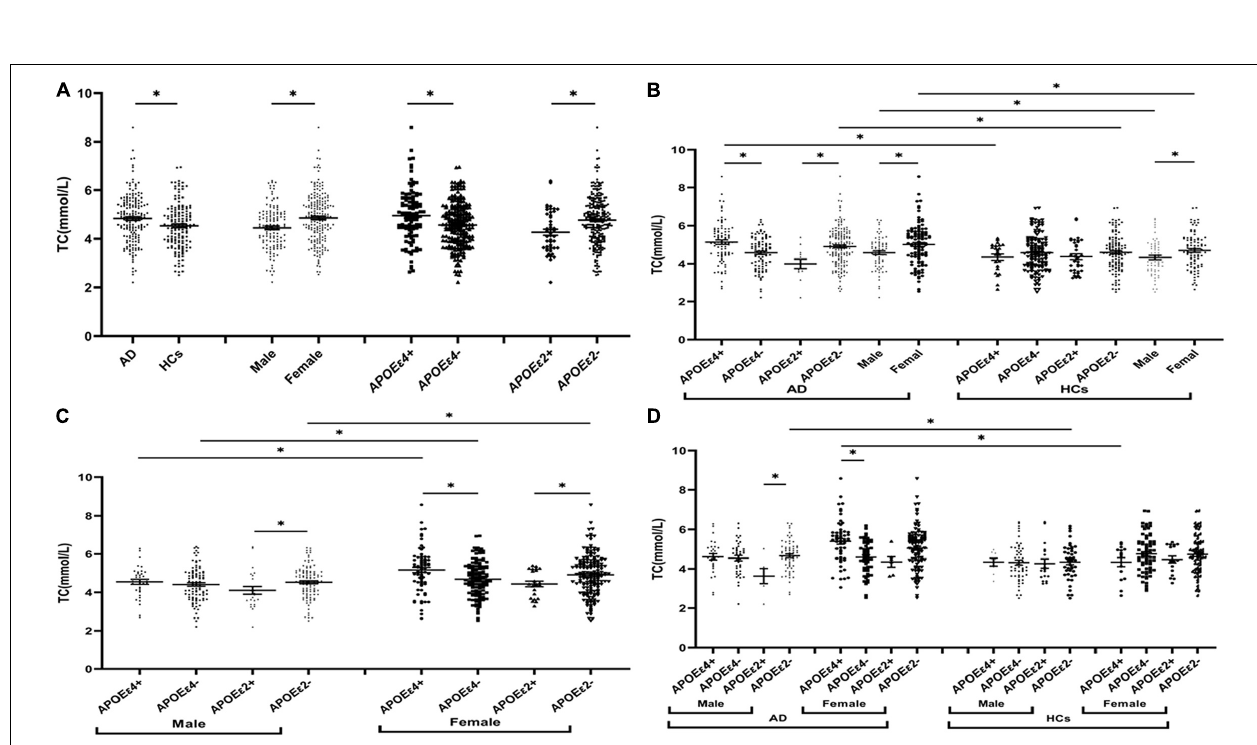
FIGURE 2 | The levels of TC in different populations. ∗ P < 0.05; Values are expressed as mean (standard error). AD, Alzheimer’s disease; HCs, healthy controls; APOE ε 4 +, APOE ε 4 carriers; APOE ε 2 +, APOE ε 2 carriers.